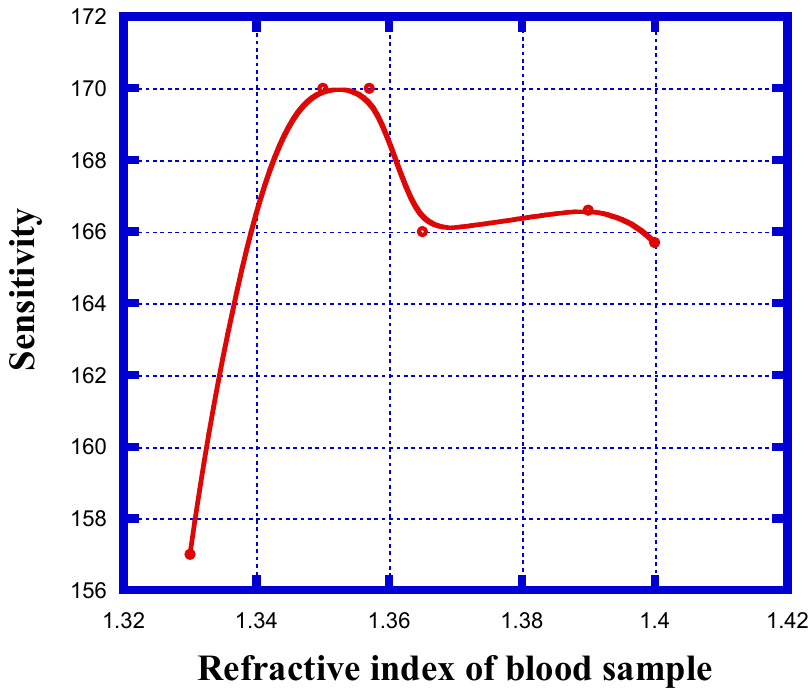
Figure 7. The sensitivity of the proposed design having a cavity thickness of d D = 200 nm as a function of the refractive index of normal and infected blood samples containing different components.